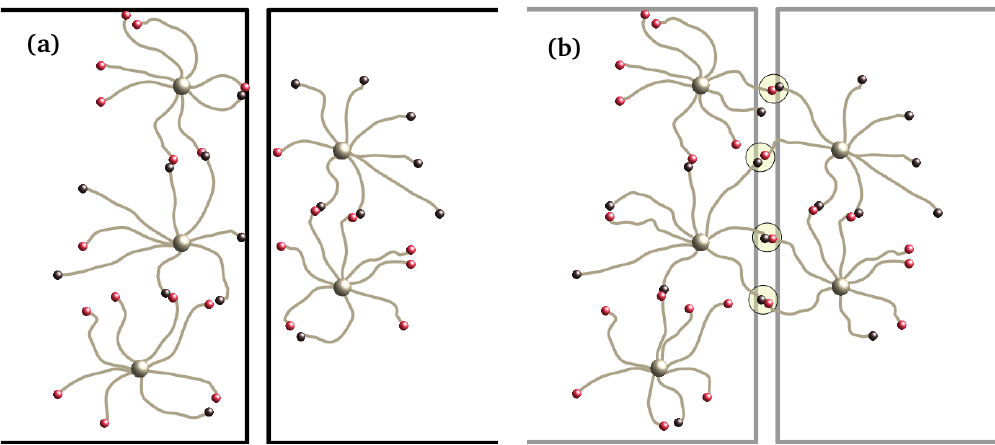
Figure 1. Sketch of swap-driven self healing. ( a ) The two halves are put in contact, but there are no bonds to connect them so they cannot sustain stress. ( b ) Through swap moves, bridges start to form. After some time, the cut will be indistinguishable from bulk. Some of the stars loop back onto themselves, forming